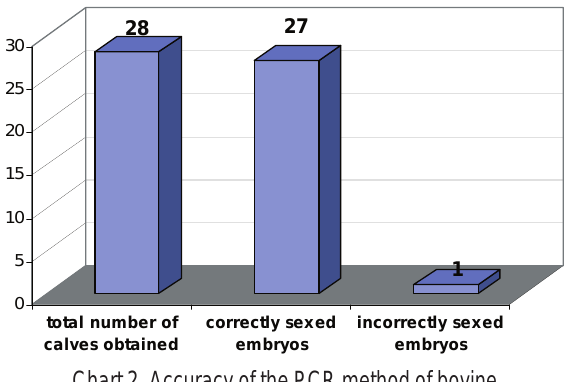
Chart 2. Accuracy of the PCR method of bovine embryo sexing